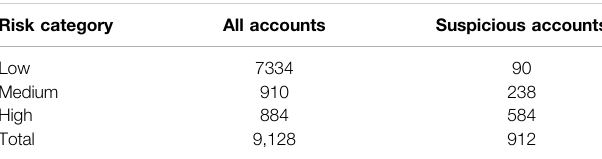
TABLE 4 | Risk categorisation of the fi fth-fold cross-validation training observations.